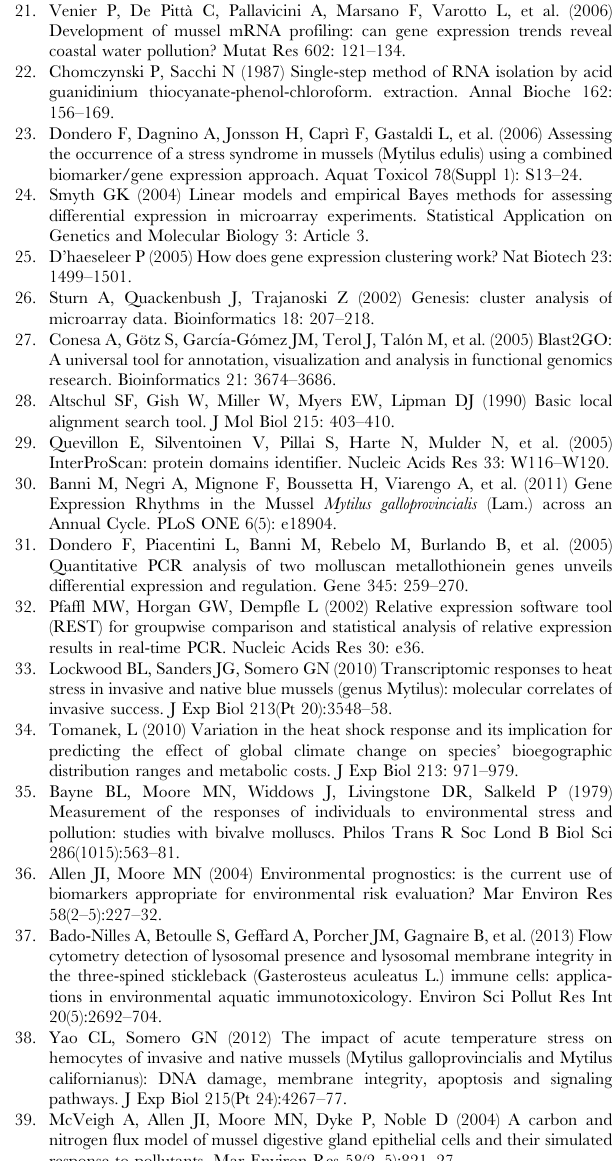
Table S5 Functional genomics analysis of Gills DEGs in animals exposed to 20 6 C and 24 6 C (against 16 6 C) (Additional information to table 3).